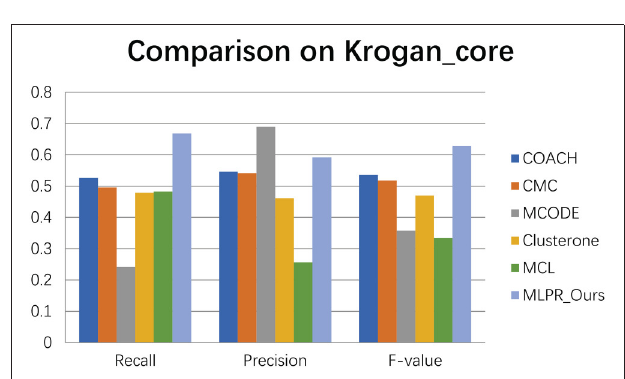
FIGURE 5 | The performances comparison between our method and other five methods on Krogan core dataset.